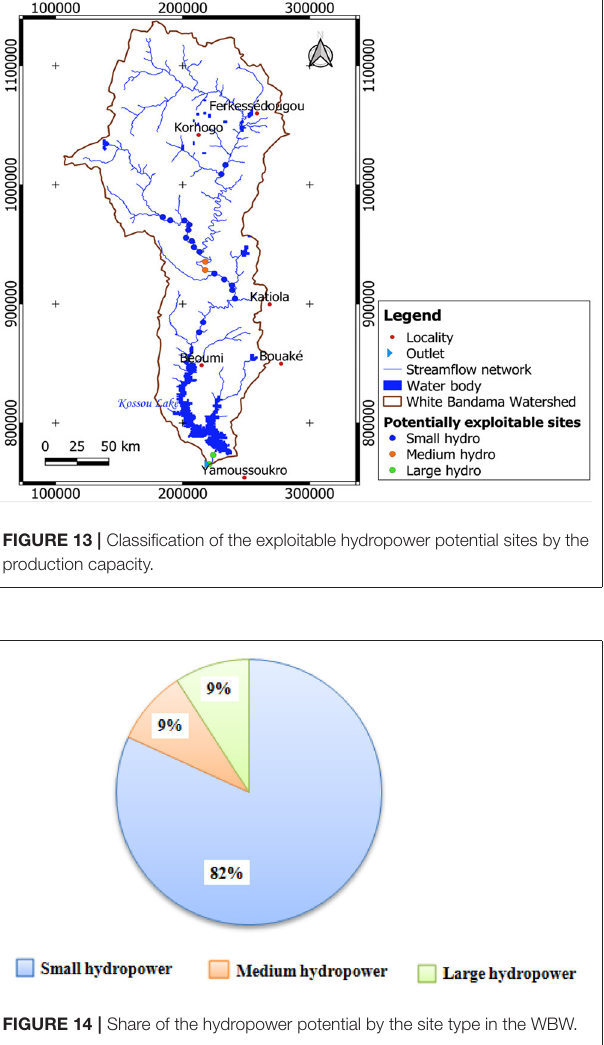
FIGURE 14 | Share of the hydropower potential by the site type in the